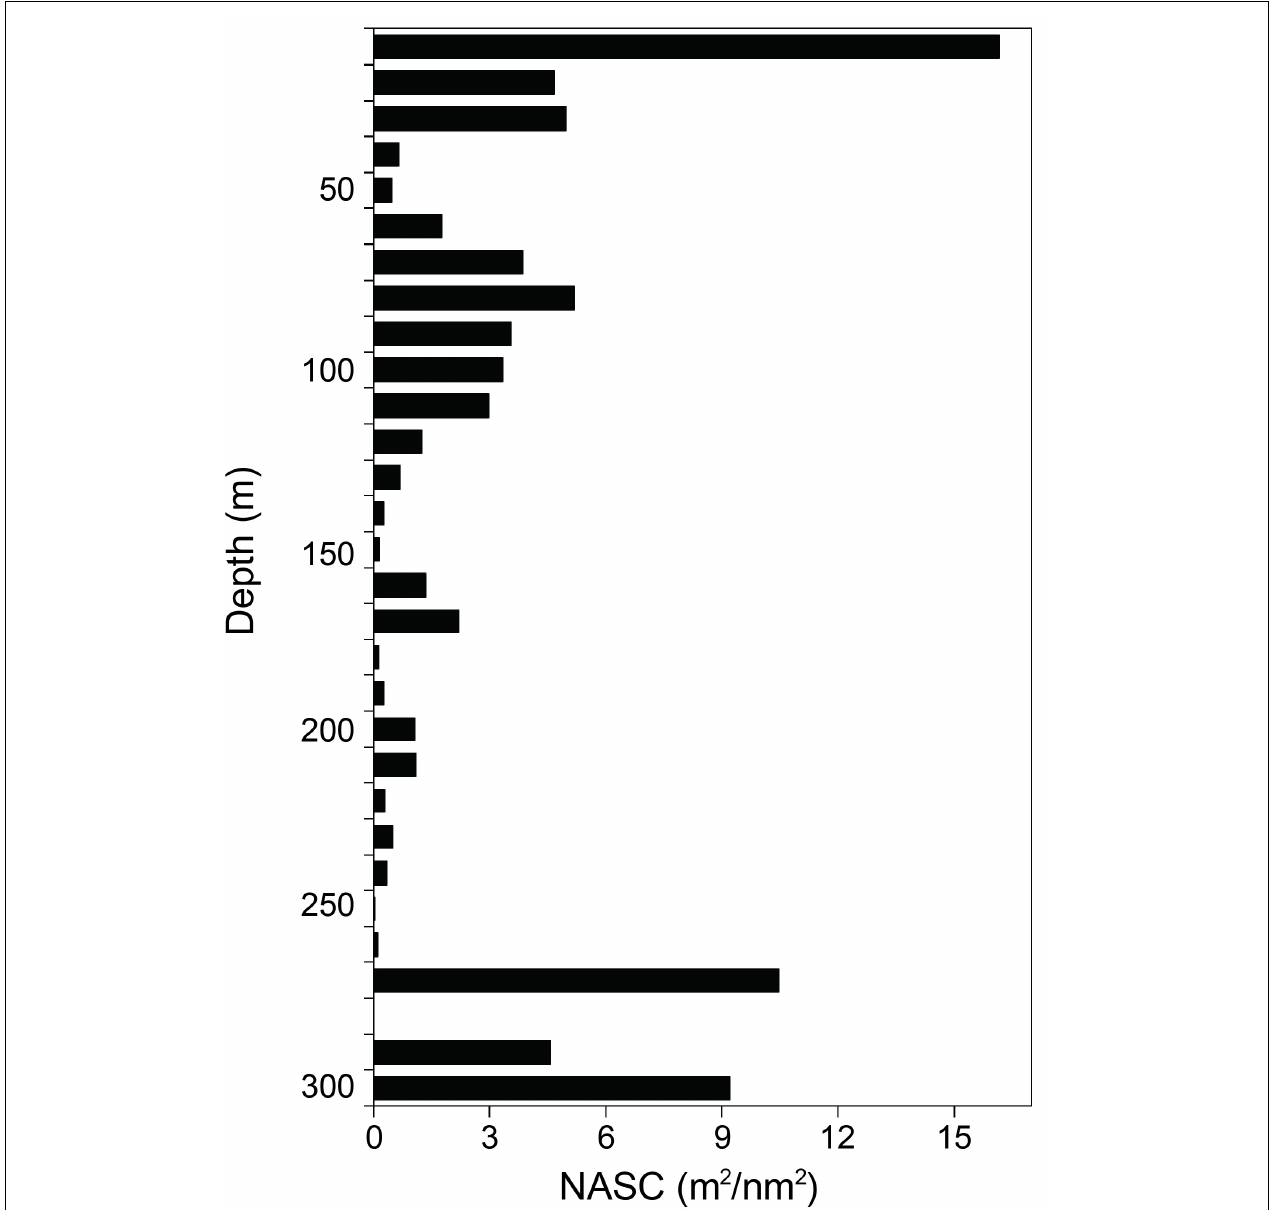
FIGURE 3 | The vertical distribution of krill NASC values, averaging every 10 m using the exported NASC in 300 m in horizontal and 10 m in vertical on 7–14 January 2019.